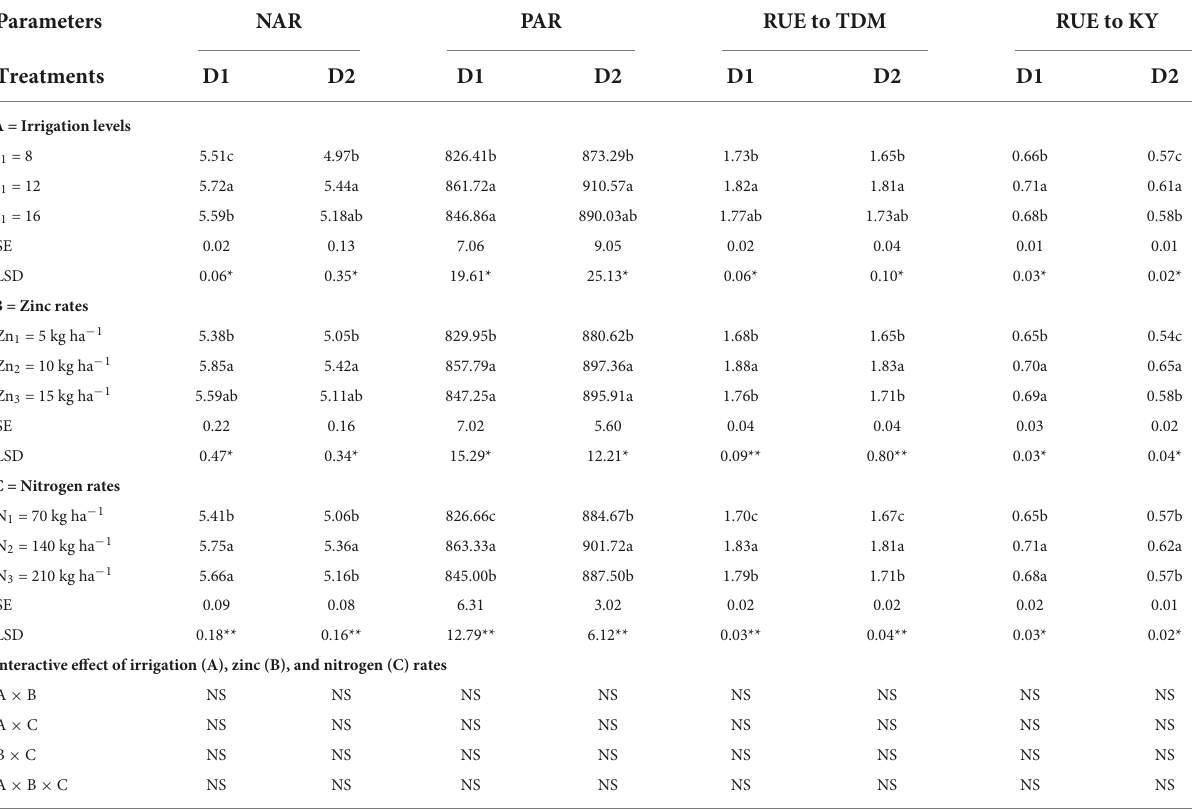
TABLE 6 Impact of zinc and nitrogen rates on net assimilation rate (NAR), photosynthetically active radiation (PAR), and radiation use efficiency (RUE) with respect to total dry matter (TDM) and kernel yield (KY) of rice cultivated under three irrigation levels at Sheikhupura (D1) and Sargodha (D2) districts of